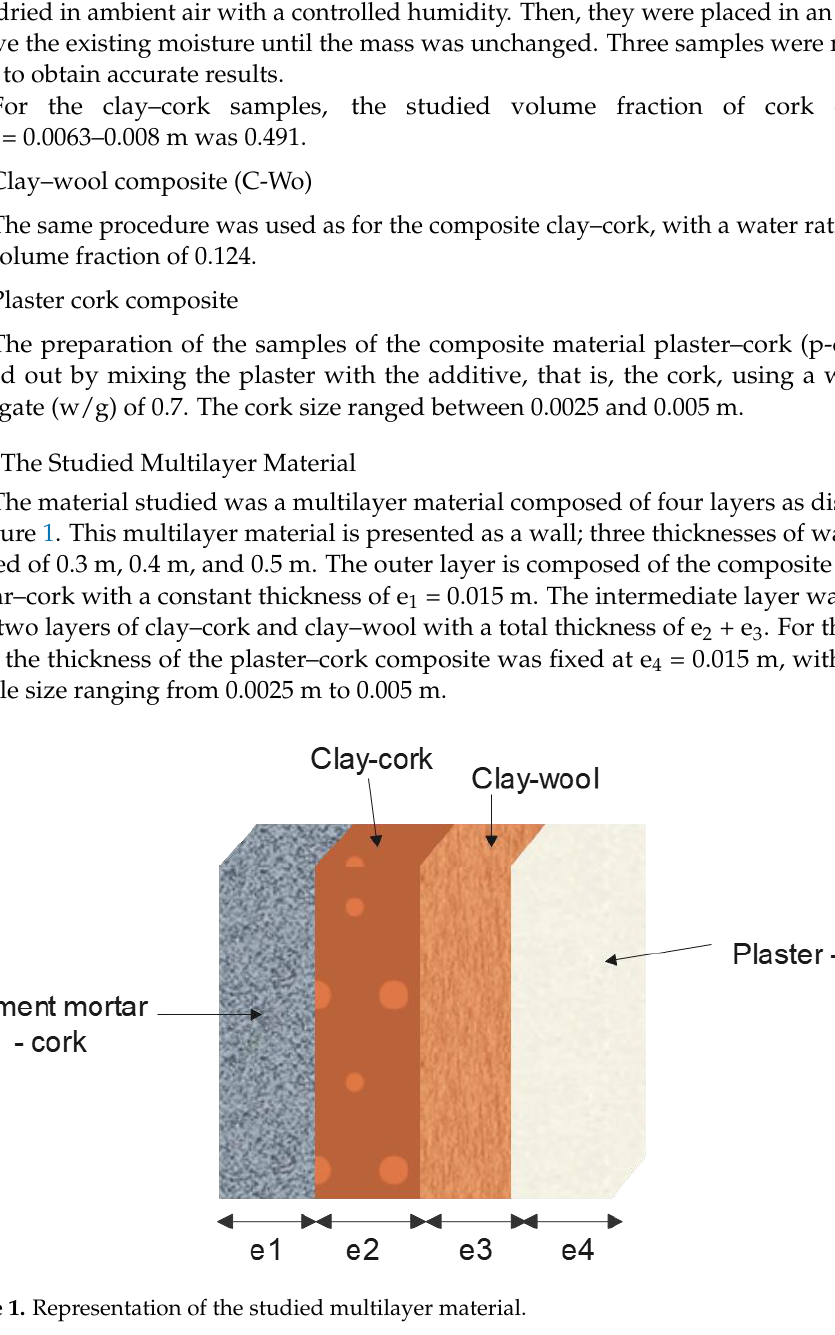
way as with the same percentages of the intermediate